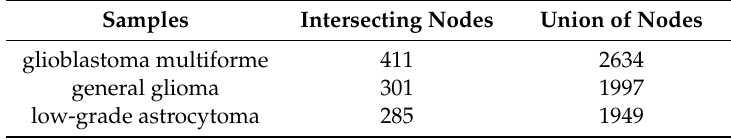
Table 2. Merge Results from StringDB and BioGRID-based disease-specific networks.